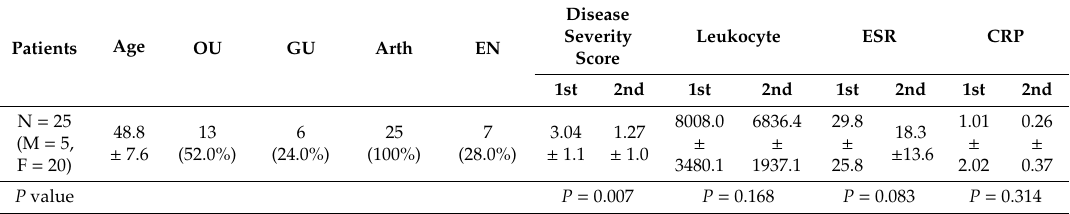
Table 1. Clinical characteristics of patients with Behçet’s disease at blood sampling.